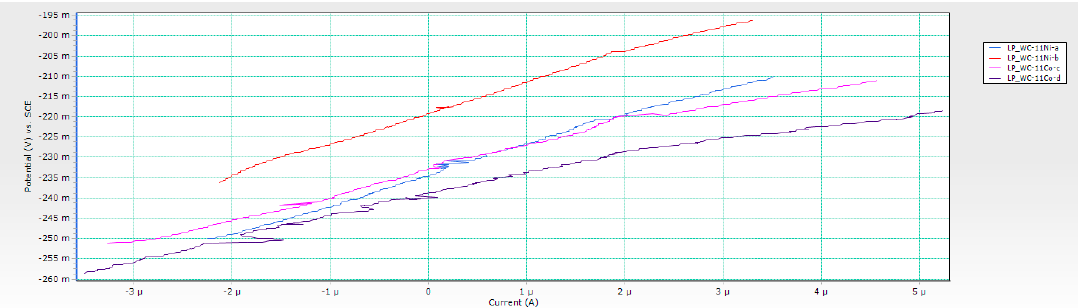
Figure 3. Linear polarization curves of samples.